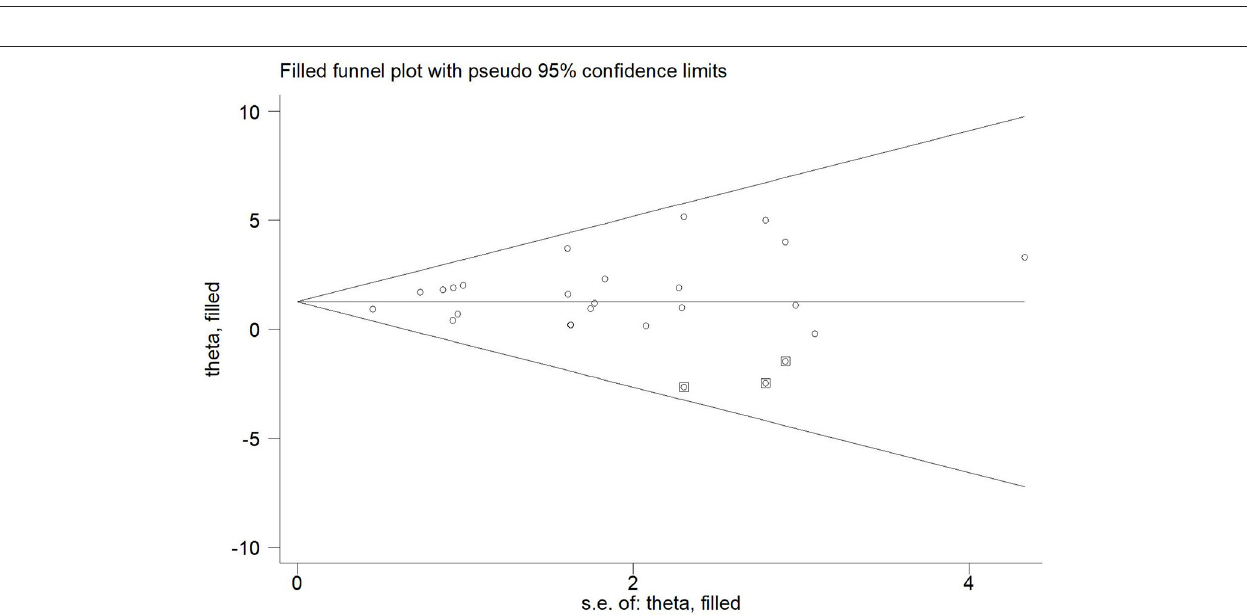
FIGURE 8 | The funnel plot showed the trim and fill method adjusted publication bias. (cid:13) , previous studies; filled